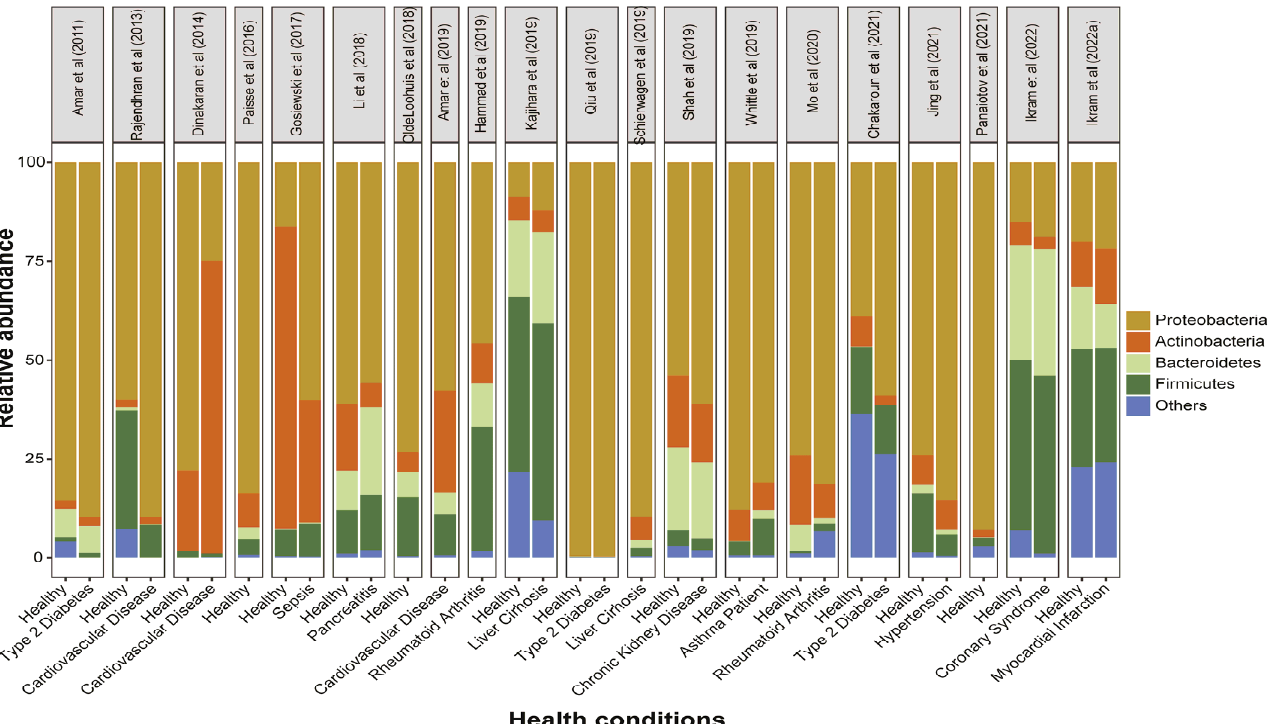
Figure 4. Phylum distribution in blood bacterial signatures from healthy and cardio-metabolic and cardiovascular disease cohorts. Each color represents a different phylum, and bar length equals the percentage of those phyla that were reported. Top pane is representing authors’ name and publication year. All studies comparing different diseases and only healthy individuals were considered.